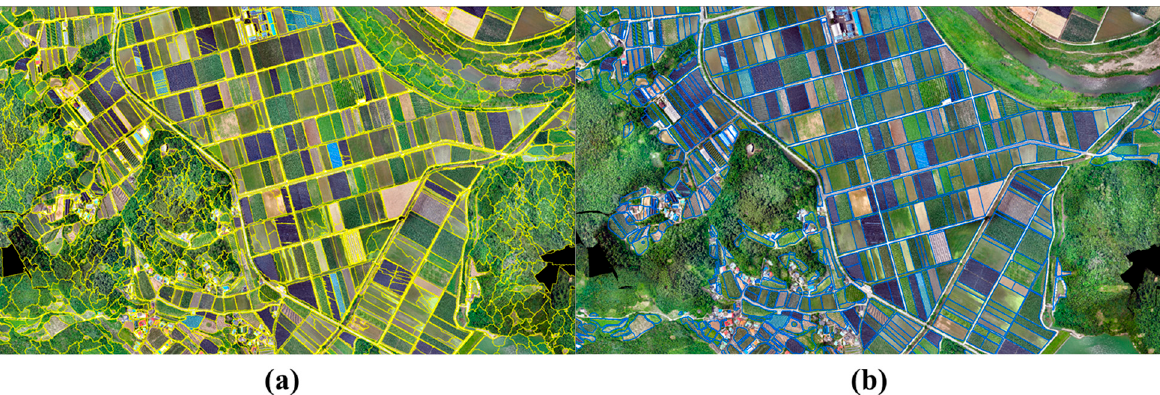
Figure 13. Comparison of farmland classification in the case of ( a ) applying the previously used region growing image segmentation method and ( b ) the Farm Map-based method.